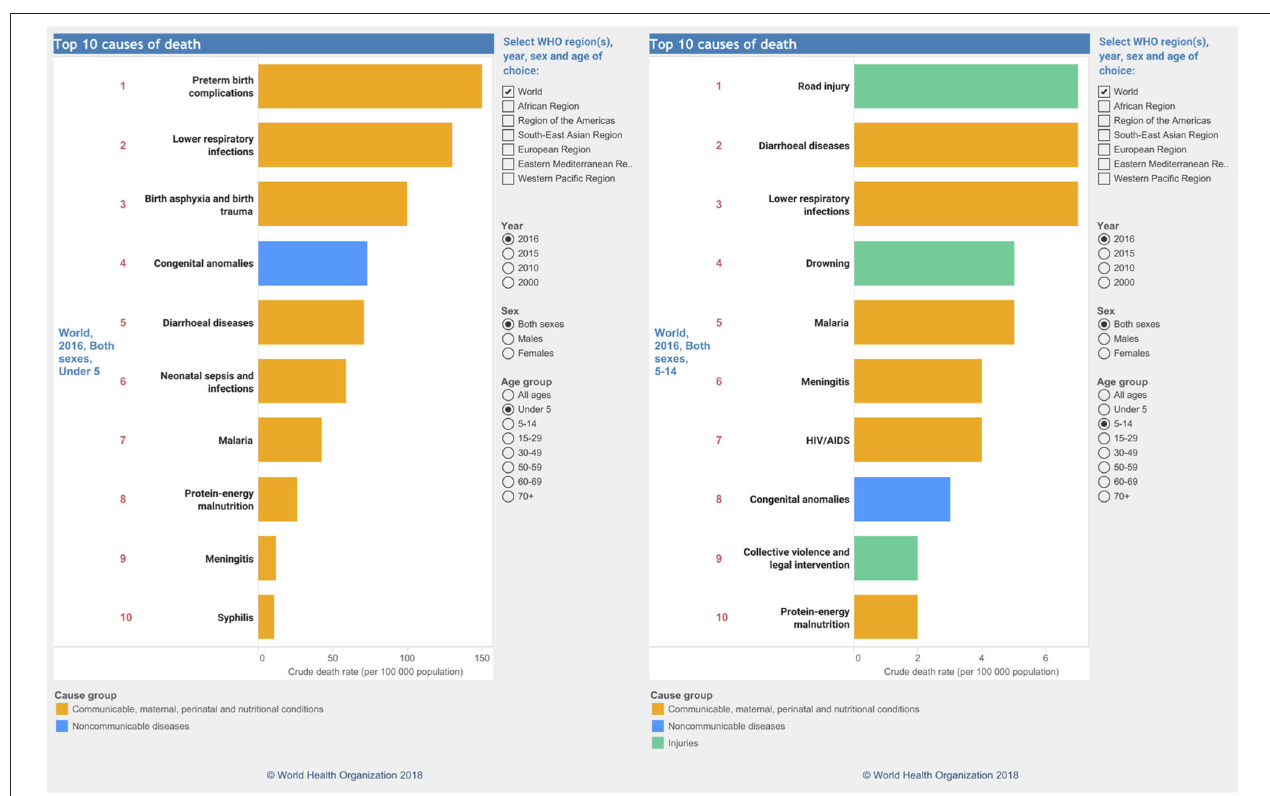
FIGURE 1 | Global causes of childhood deaths according to the WHO. Causes of deaths for the year 2016 in children from 0–5 in age (left) and 5–14 (right). Data were taken and reproduced with kind permission from the website of the World Health Organization